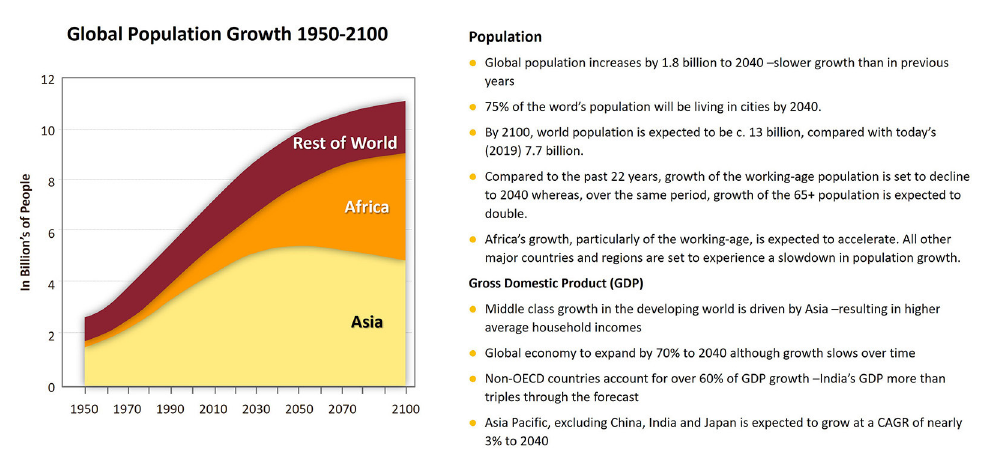
Fig. 8. – Global population growth, 1950–2100 and population and Gross Domestic Product (GDP) trends to 2040.